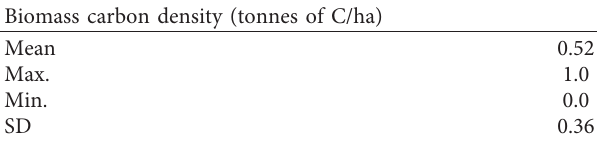
Figure 3: NDVI map for years (a) 2000, (b) 2011, and (c) 2020. Table 4: Basic statistics of above and below ground living biomass carbon density of the